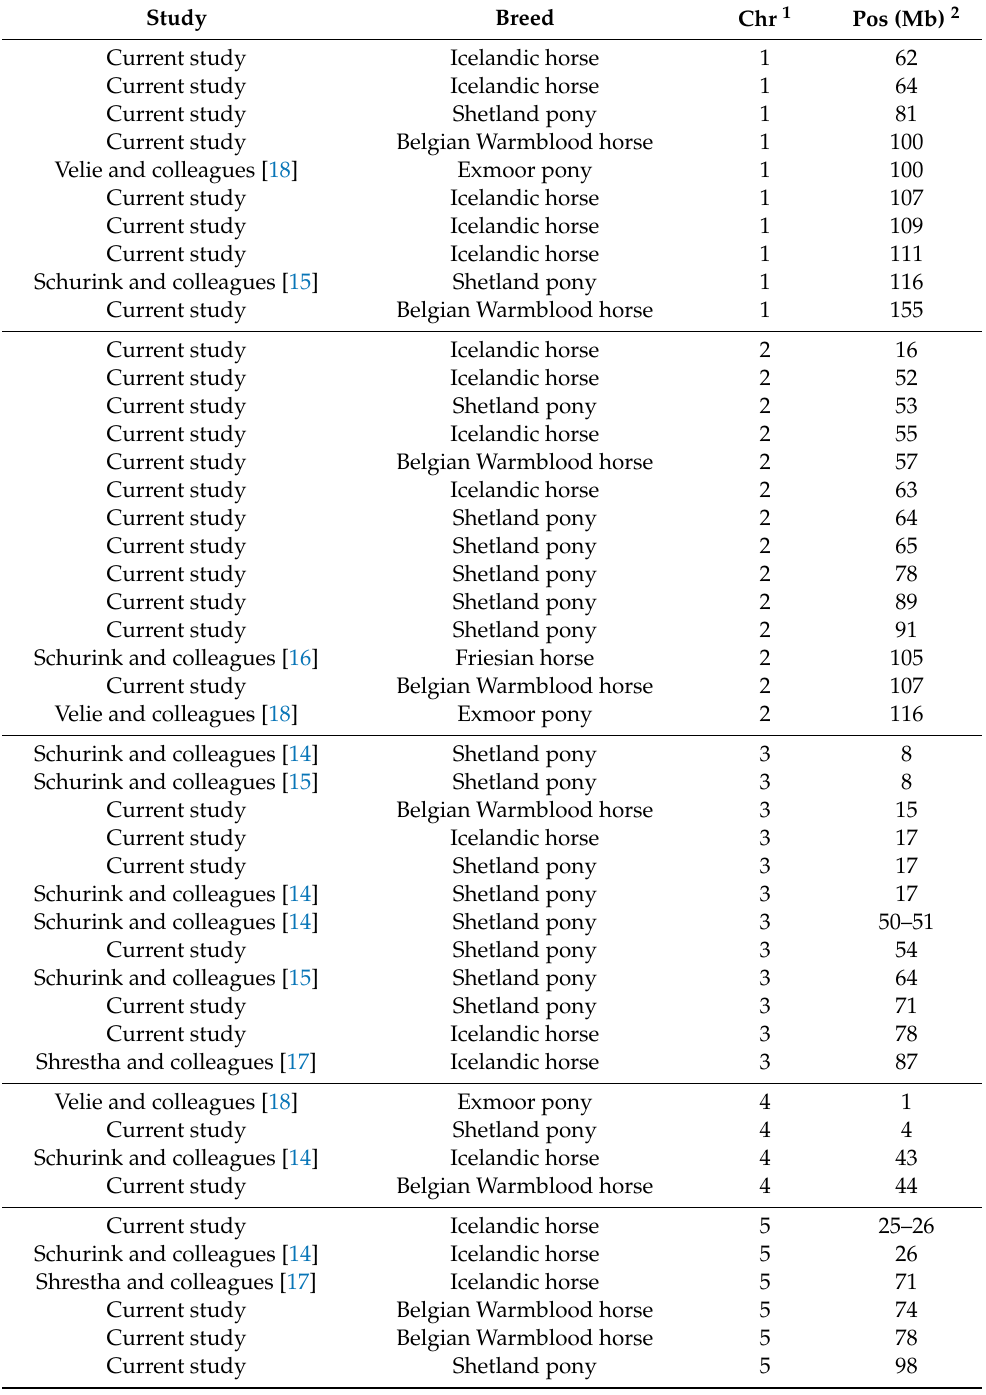
Table A3. Comprehensive list of regions associated with antigen-specific IgE levels identified in any of the three investigated breeds, along with previously identified genomic regions through a case-control approach in